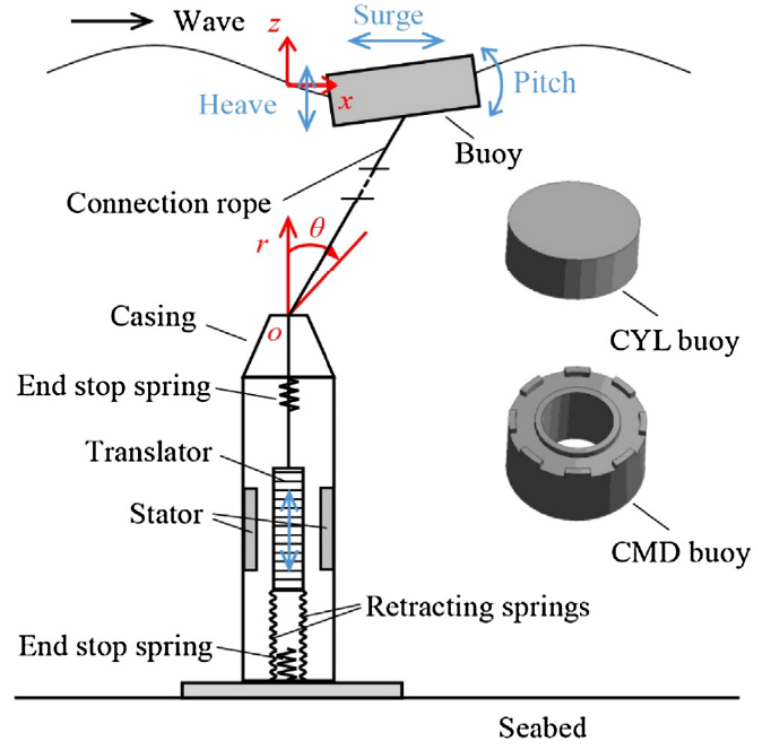
Figure 3. Schematic of a point absorber with a linear generator PTO [56] .